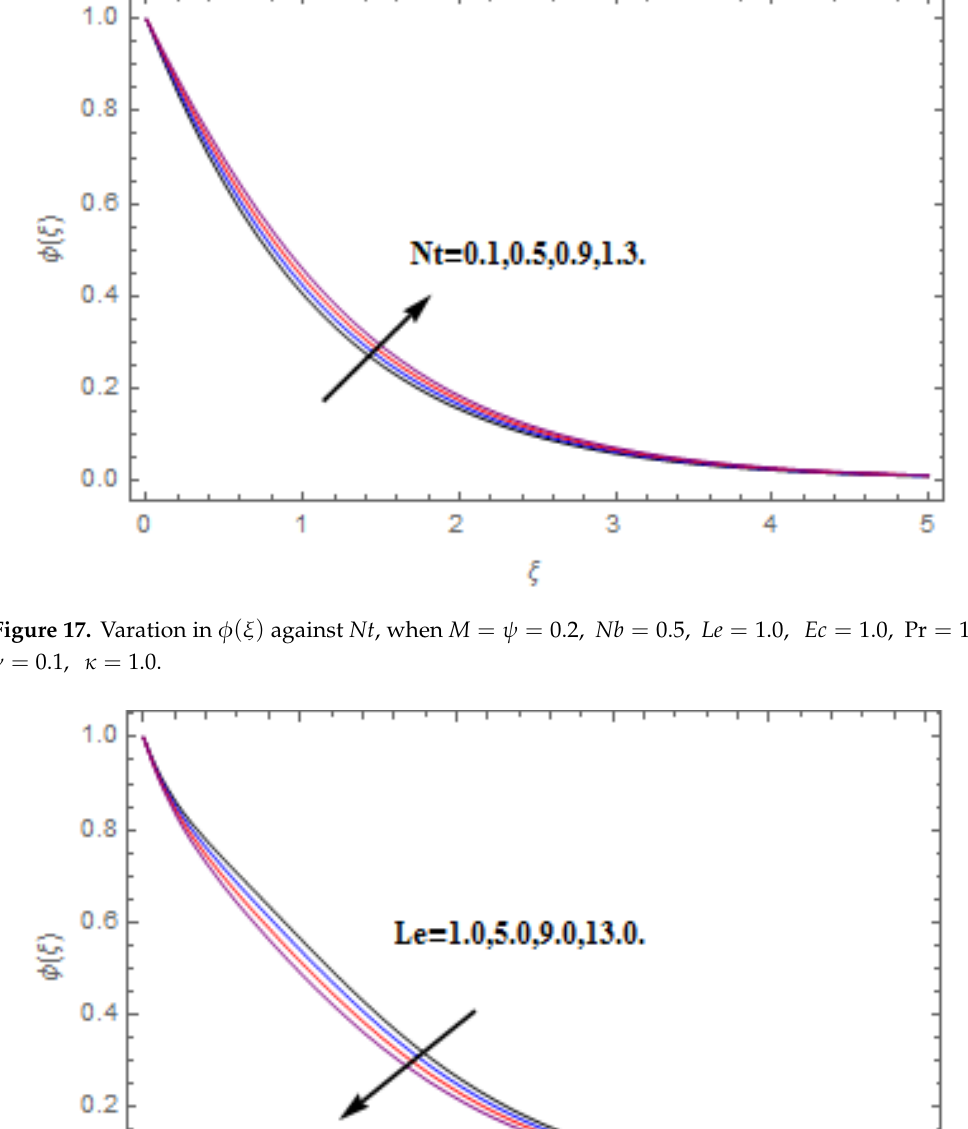
C and C against M ,  , and  . f g